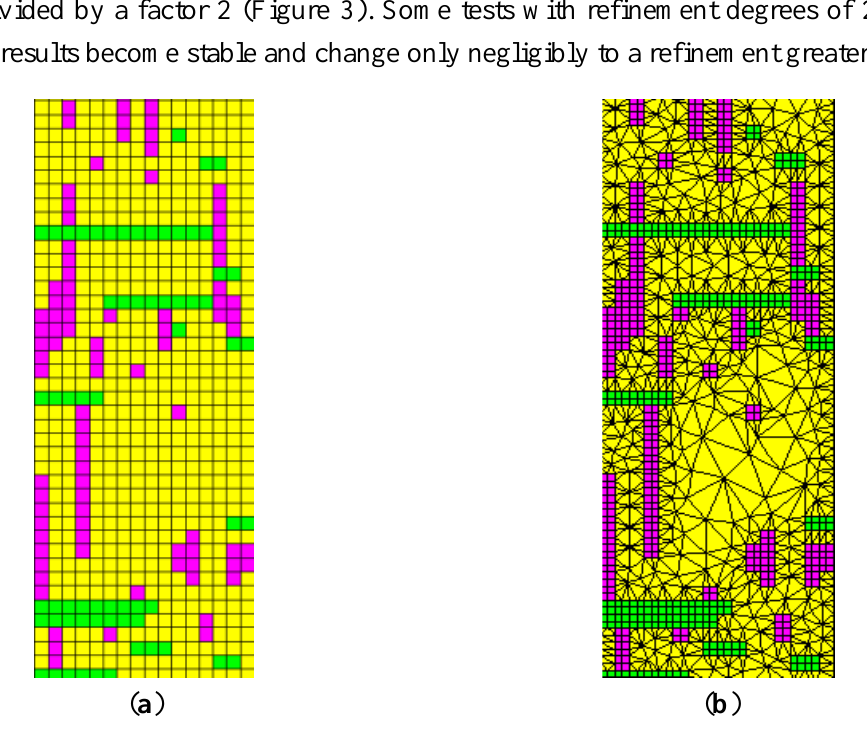
Figure 3. Examples of NF network and matrix mesh for effective modeling of NF network reinforcing matrix. ( a ) Initial mesh; ( b ) Mesh after NF refinement and matrix